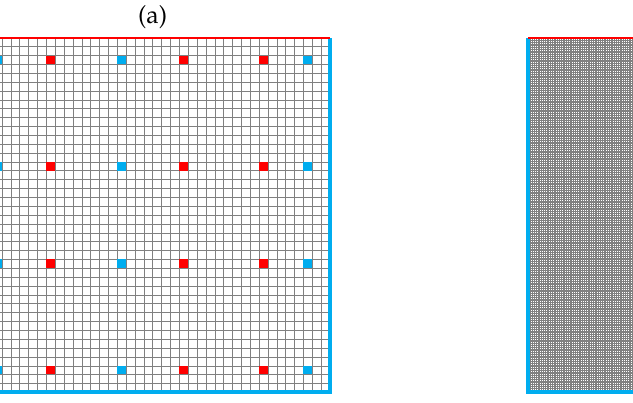
Figure 3. Numerical grids employed for the test case (not in scale). ( a ) medium-refined grid with 3600 elements and space discretization 0.002 m, used for the integrated algorithm. The blue and red dots represent, respectively, the locations where the artificial observation for velocity and temperature are taken. ( b ) High-refined grid with 100,000 elements and space discretization 0.00001 m, used to evaluate the reference CFD solution and to extract the synthetic data used as observation.